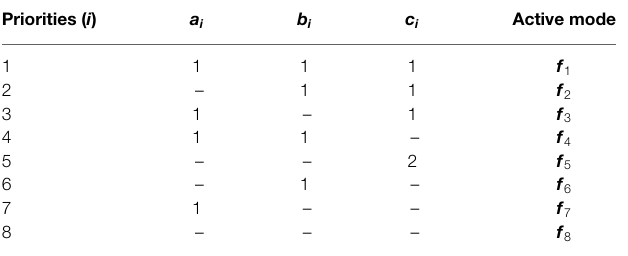
TABLE 8 | Table illustrating the activation of mode in example 2 .